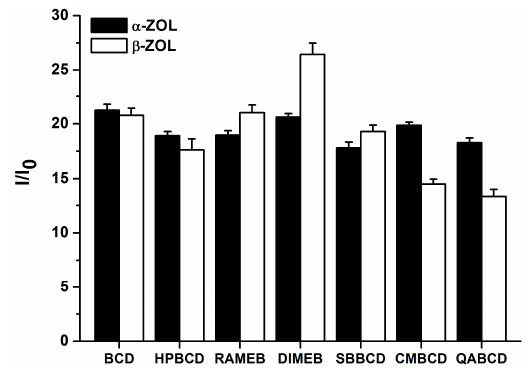
Figure 5. Fluorescence enhancement (I/I 0 ) of α -ZOL (2 μ M) and β -ZOL (2 μ M) in the presence of 2 mM CD concentration in 0.05 M sodium acetate (pH 5.0) buffer ( λ exc = 275 nm, λ em = 455 nm).